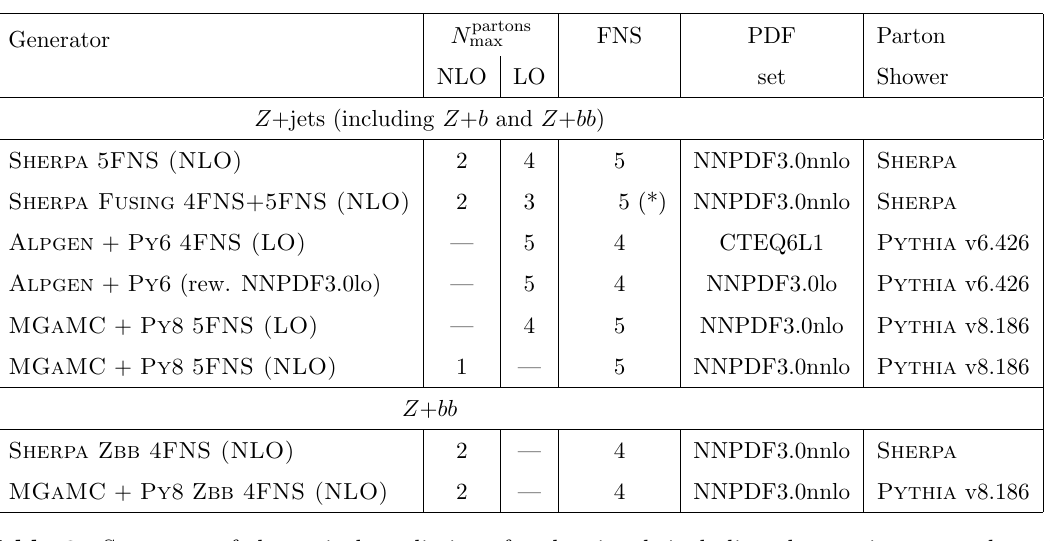
Table 2 . Summary of theoretical predictions for the signal, including the maximum number of partons at each order in (cid:11) S , the (cid:13)avour number scheme (FNS), the PDFs set and the parton shower. (*) Details of the merging between 4FNS and 5FNS in Sherpa Fusing 4FNS+5FNS (NLO) are available in ref.